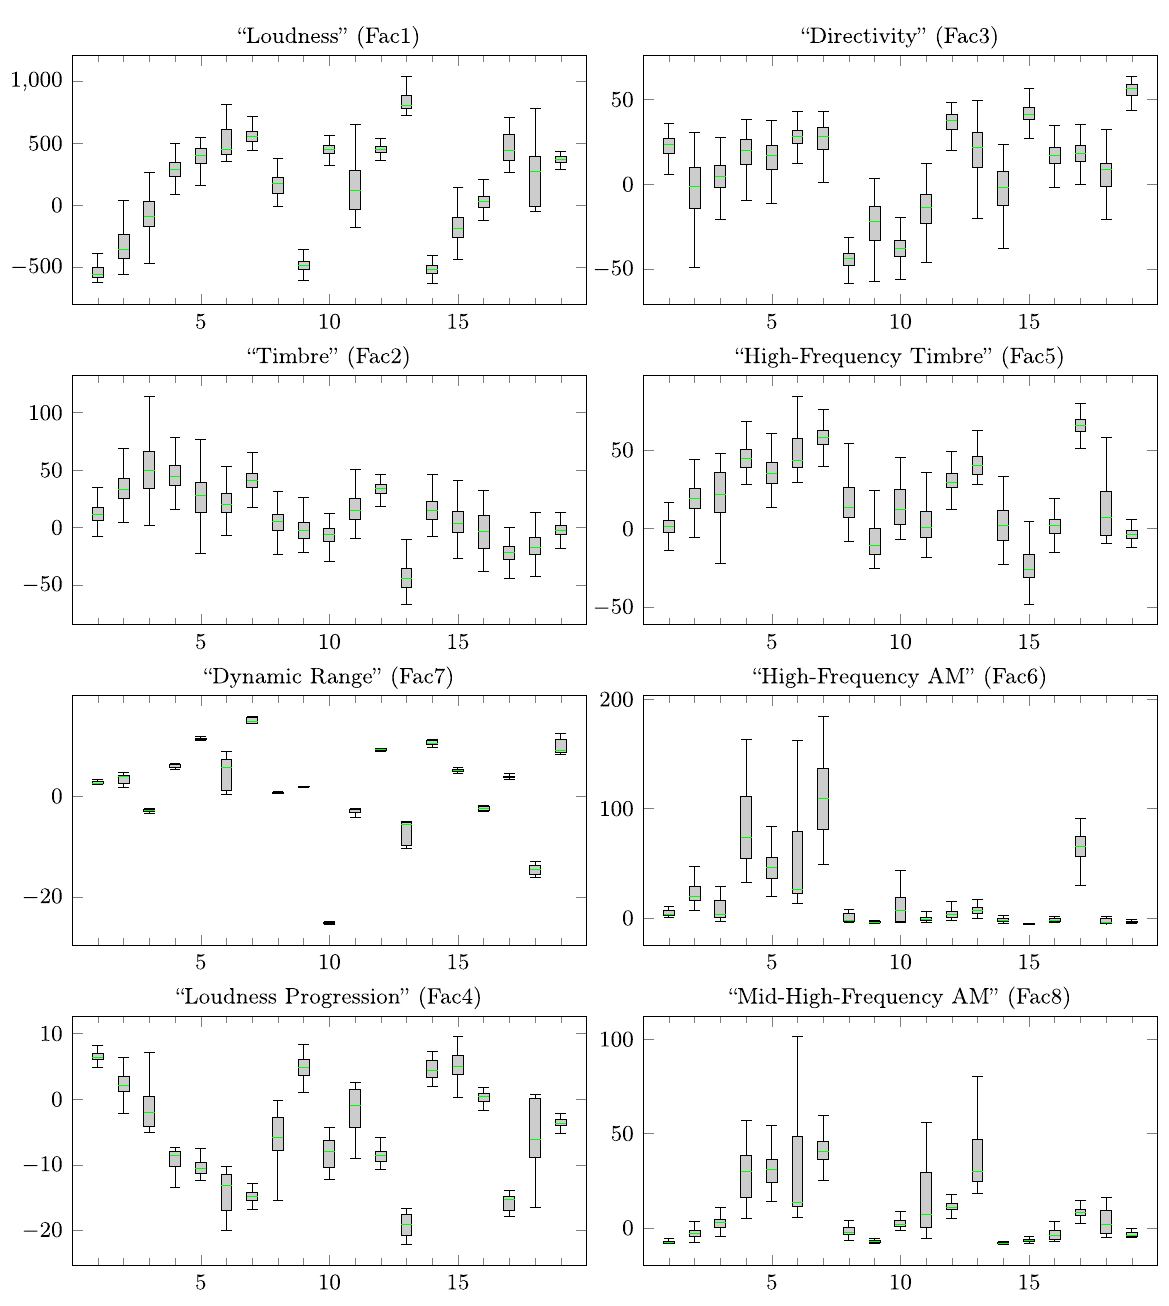
Figure 3. Distribution of factor scores amongst the soundscape recordings for each relevant